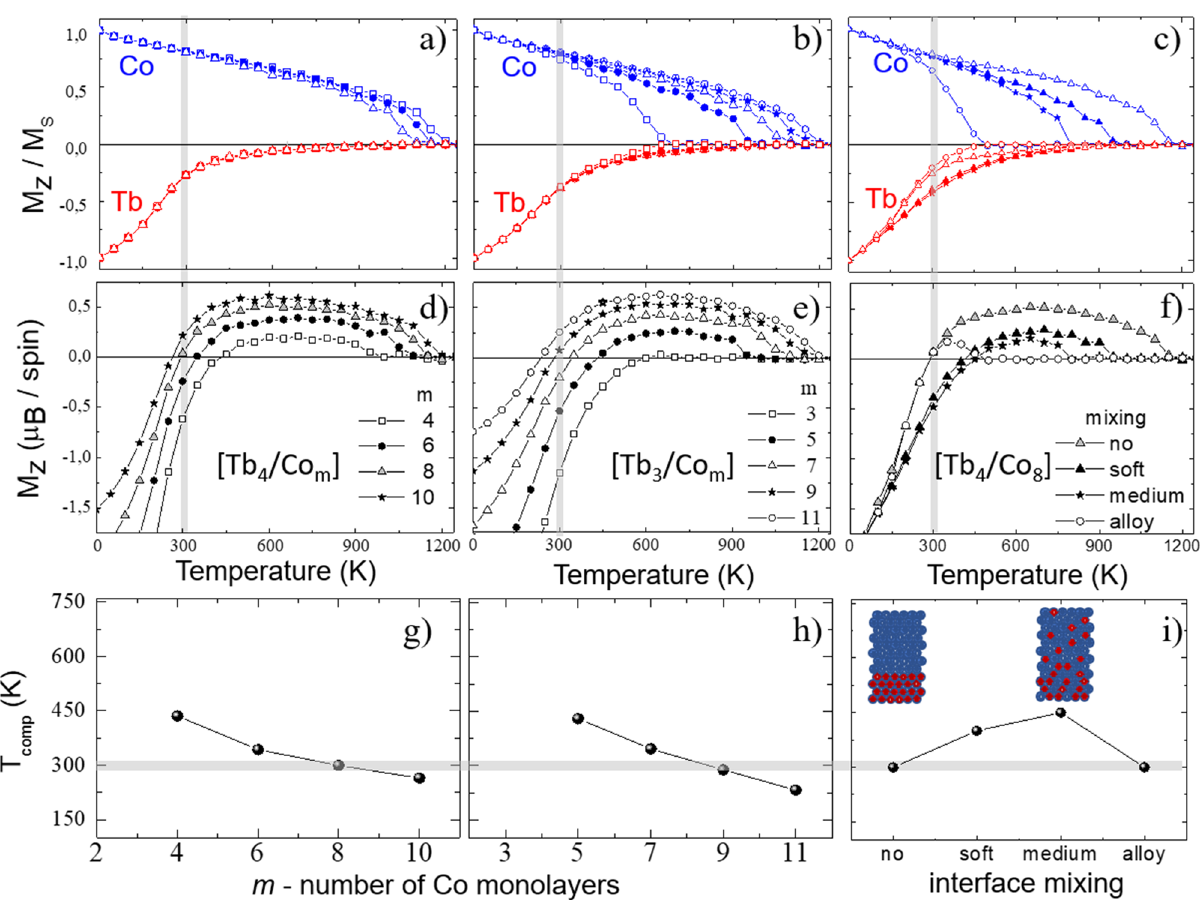
Figure 1. Thermal variation of magnetization of [ Tb n / Co m ] multilayers. The subscripts indicate the number of atomic layers. ( a – c ) Normalized thermal variation of the magnetization of Tb and Co sublattices. ( d – f ) Reduced magnetic moment of sample [ Tb n / Co m ]. Compensation temperature as a function of the number of Co monolayers ( g ), ( h ) and intermixing ( i ). The insets from ( i ) show the composition of the sample with perfect interfaces and medium intermixing respectively. The grey lines indicate the room